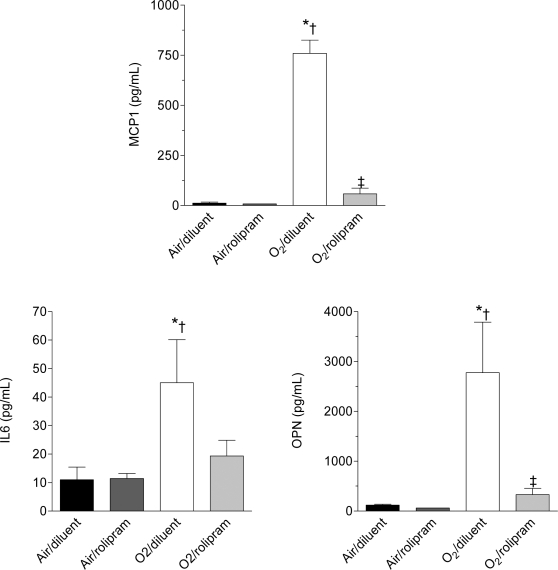
Concentration of selected chemokine (MCP1) and cytokines (IL-6 and OPN) in BAL of rat pups exposed to hyperoxia and treated or not with rolipram.Concentrations of MCP-1, IL-6, and OPN were measured by multiplex ELISA in BAL fluid, collected at day 6 of life from rat pups exposed to normoxia or hyperoxia from birth and either treated with rolipram (n = 4 or 5/group) or receiving the diluent alone (littermate controls, n = 4 or 5/group). Data are expressed as mean±sem. * Significantly different from the air-diluent group; †significantly different from the air-rolipram group; ‡ significant difference between oxygen-diluent and oxygen-rolipram groups.